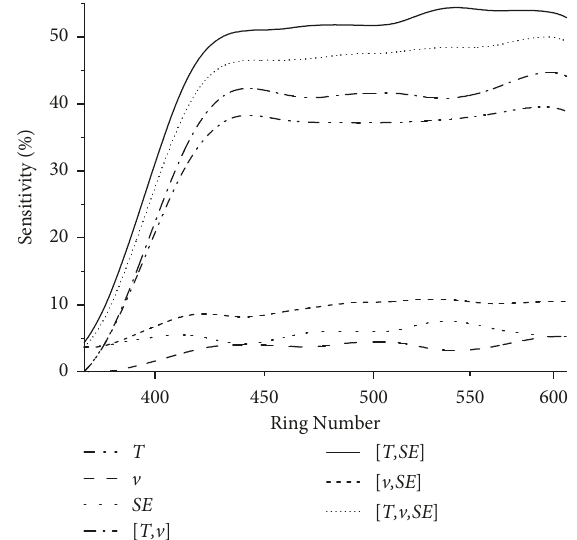
Figure 7: Sensitivity of tunneling parameters to strata identifi- cation